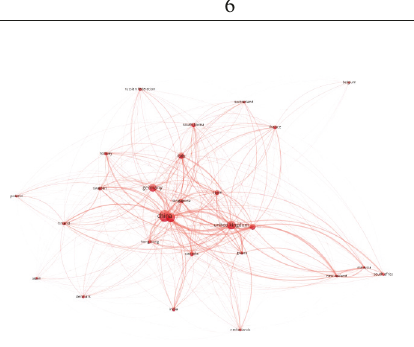
Figure 6: Network of